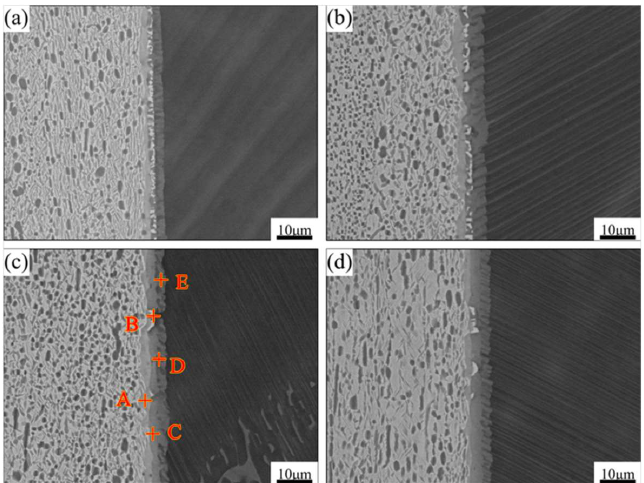
Figure 4. Interfacial microstructure of bonded joints for 60 min/5 MPa at different temperatures. ( a ) 930 ◦ C, ( b ) 950 ◦ C, ( c ) 970 ◦ C, ( d ) 990 ◦ C, and ( e ) 1010 ◦ C.